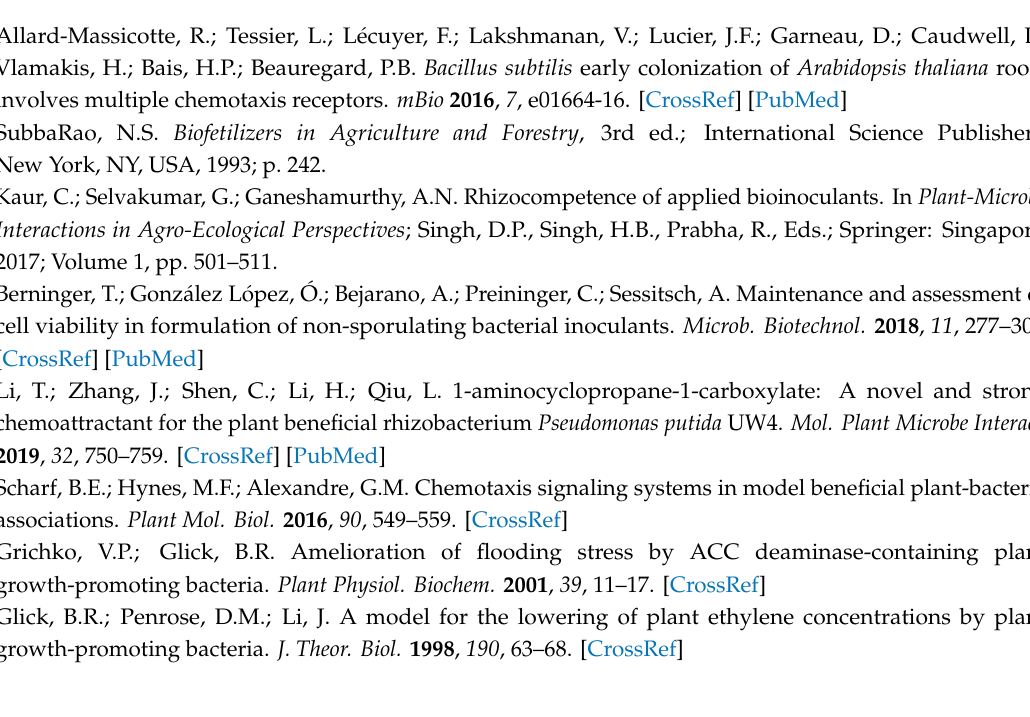
Figure S1. DNA electrophoresis of pBBR1MCS2 and derivative vectors extracted from Pseudomonas sp. UW4 ∆ AcdS transconjugants and the Bam HI- Hind III-digested productions of the vectors. Figure S2. PCR products corresponding to the AcdS (A) and kanamycin resistance gene (B) amplified from Pseudomonas sp. UW4 ∆ AcdS and transconjugants. Figure S3. The growth curves of Pseudomonas sp. UW4 and derivative strains growing on LB medium (A) and glycerol salt medium containing ACC as sole nitrogen source (B). Figure S4. The e ff ects of Pseudomonas sp. UW4 strains inoculation on wheat root dry weight in Pot trial. Table S1. Primers used in this